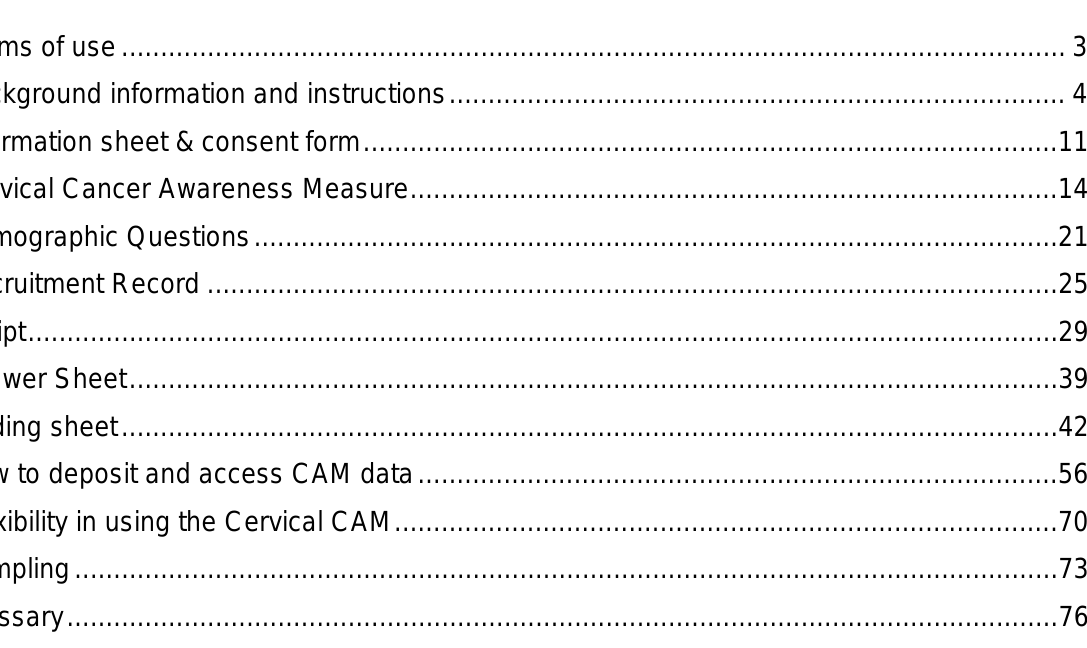
Cervical Cancer Awareness Measure Toolkit Version 2.1 Updated